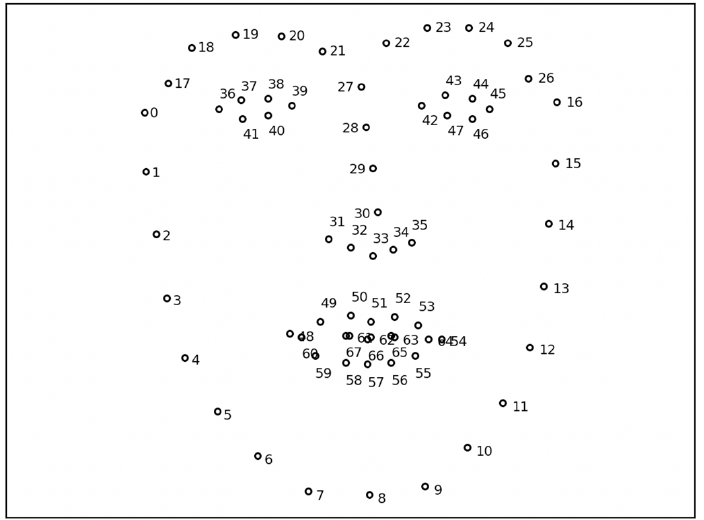
Figure 1. Detection of the 68 facial landmarks by the OpenFace library in a face image collected by the robot’s camera.